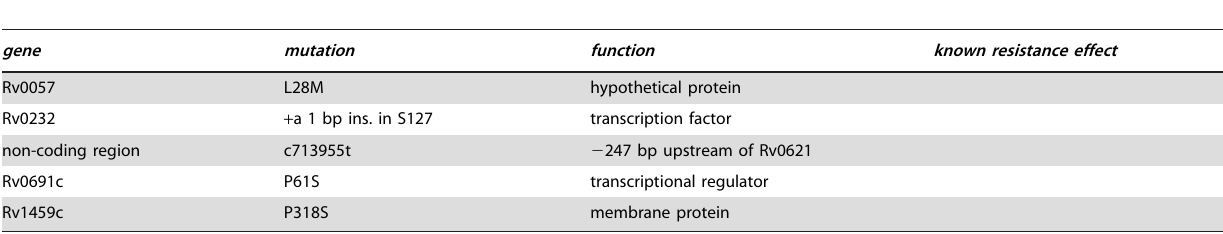
This table excludes synonymous mutations in coding regions, and mutations in PPE/PGRS genes or repetitive sequences. Mutations in coding regions are numbered as amino acids substitution (upper case). Numbering of base substitutions (lower case) in non-coding regions is given relative to the H37Rv genome.